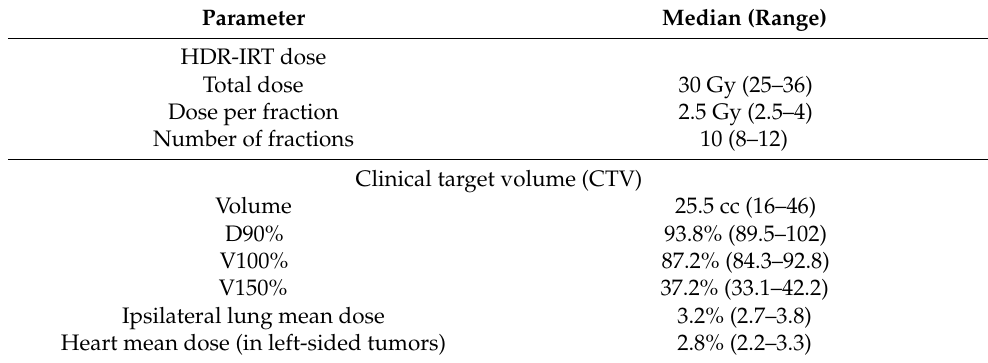
Table 2. Dosimetry parameters of the